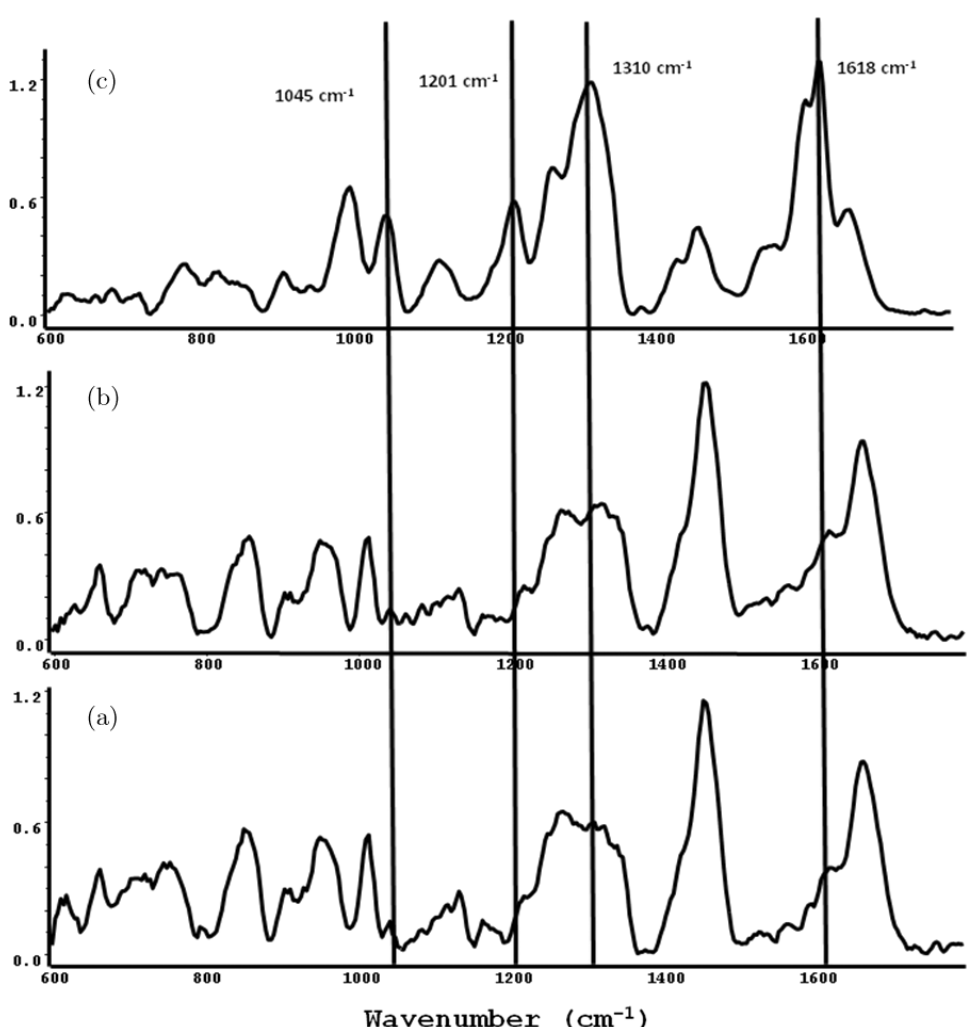
Fig. 2. Representative spectra for DCDR approach in drug spiked and blank plasma. DCDR approach was explored to achieve lower detection limit for Imatinib. Spectra were acquired from dried drop of Imatinib spiked plasma for concentrations 2, 1, 0.1 mg/ mL and blank plasma. Imatinib-speci¯c signals could be observed till 0.1 mg/mL; (a) blank plasma, (b) Lowest concentration: 0.1mg/mL, (c) Intermediate concentration: 1 mg/mL, (d) Highest concentration: 2